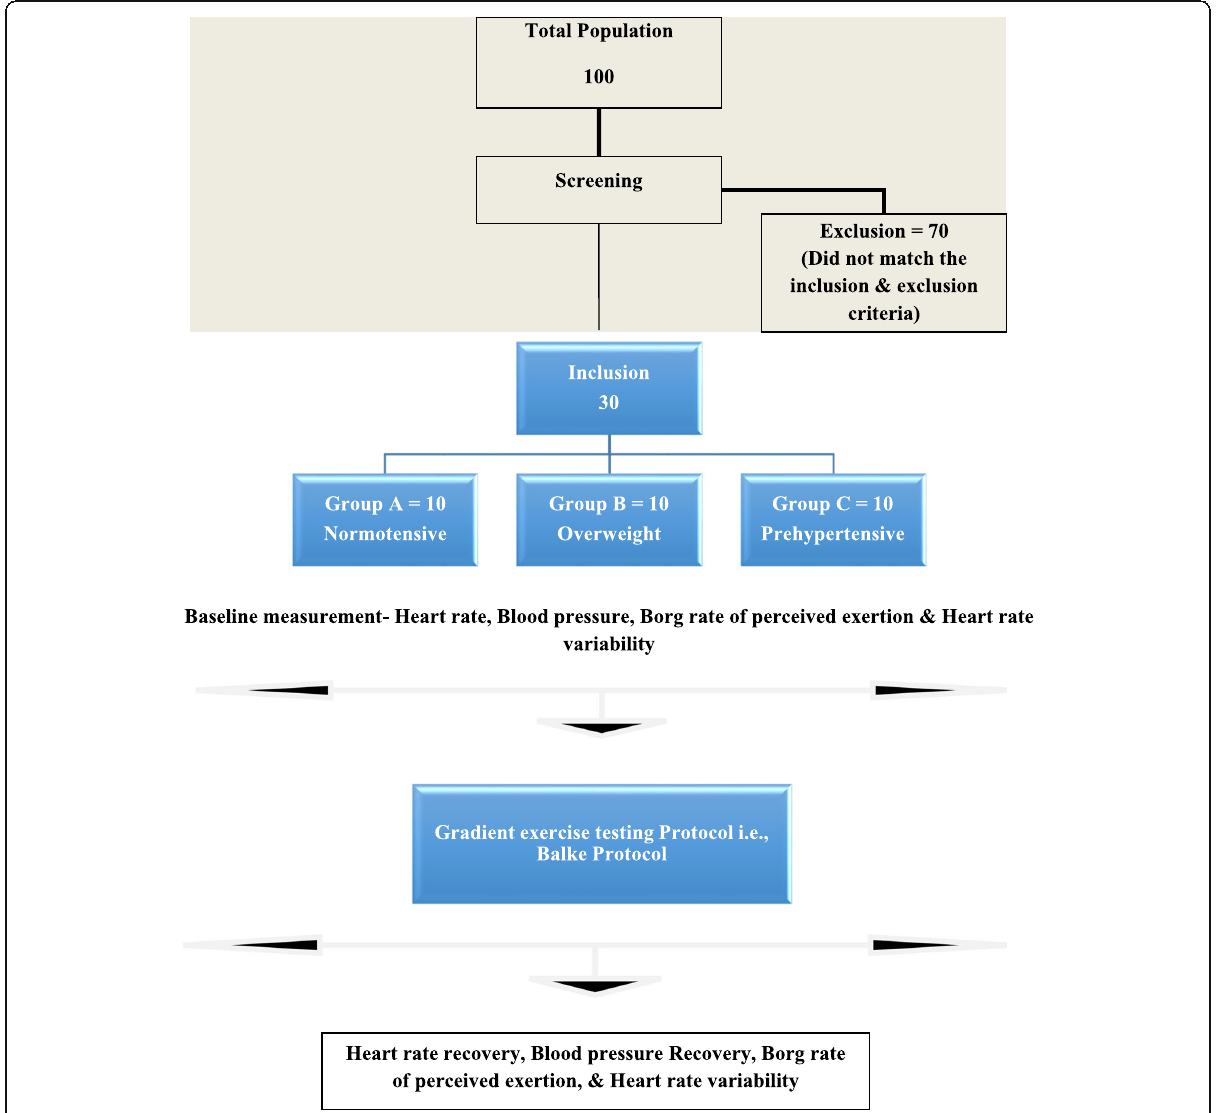
Fig. 1 Flowchart 1 —